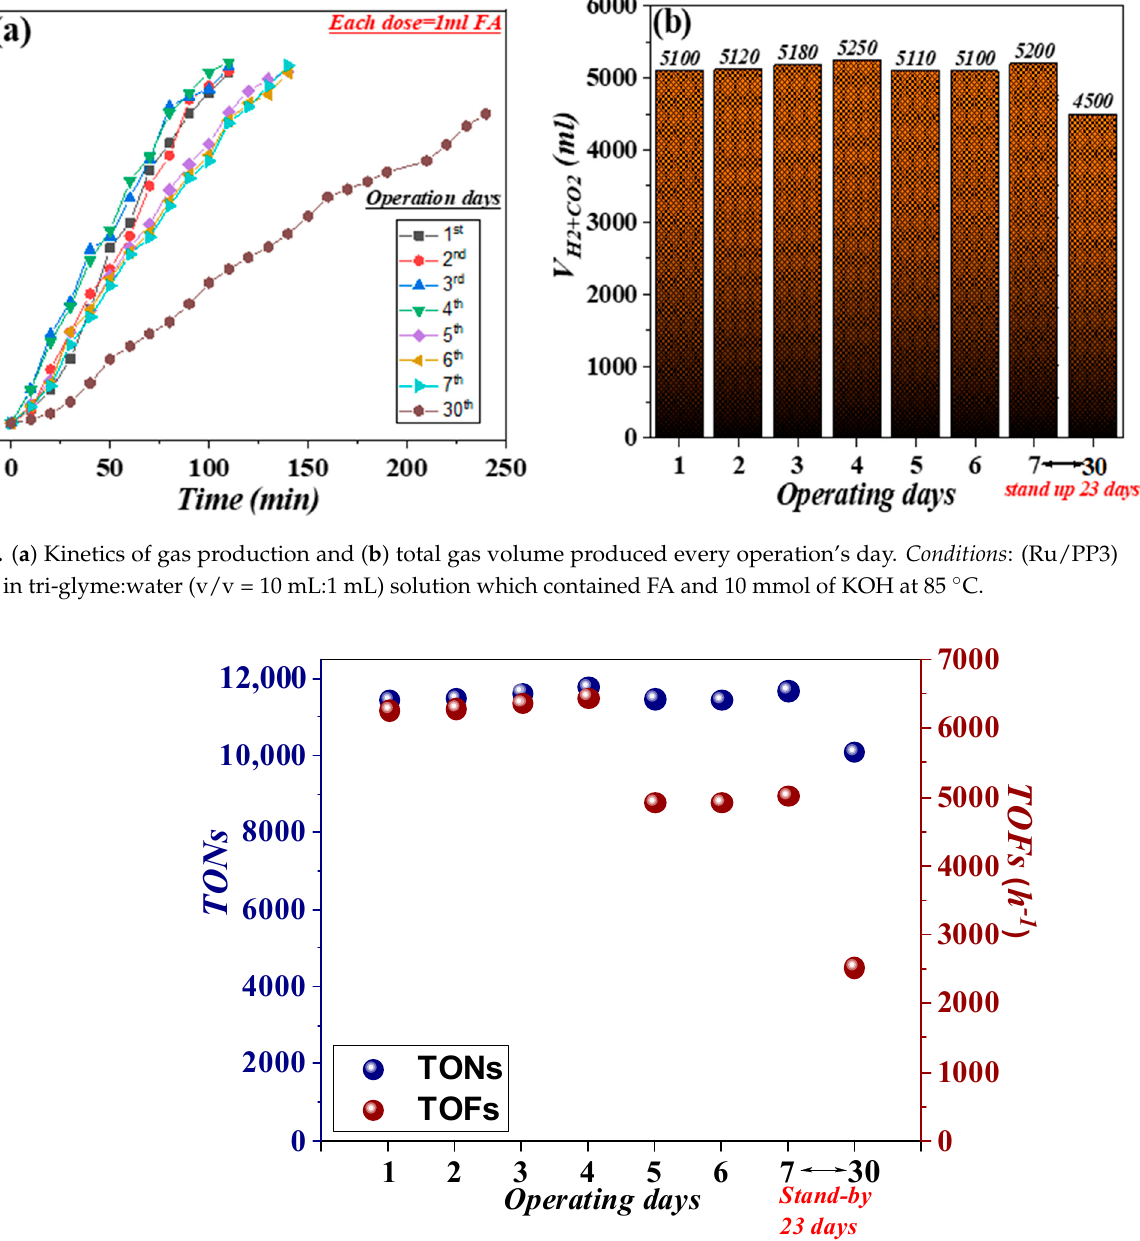
Figure 2. TONs and TOFs measured on each operation day. Conditions: (Ru/PP3) (9 μ mol) in tri-glyme:water (v/v = 10 mL:1 mL) solution which contained FA and 10 mmol of KOH at 85 °C.